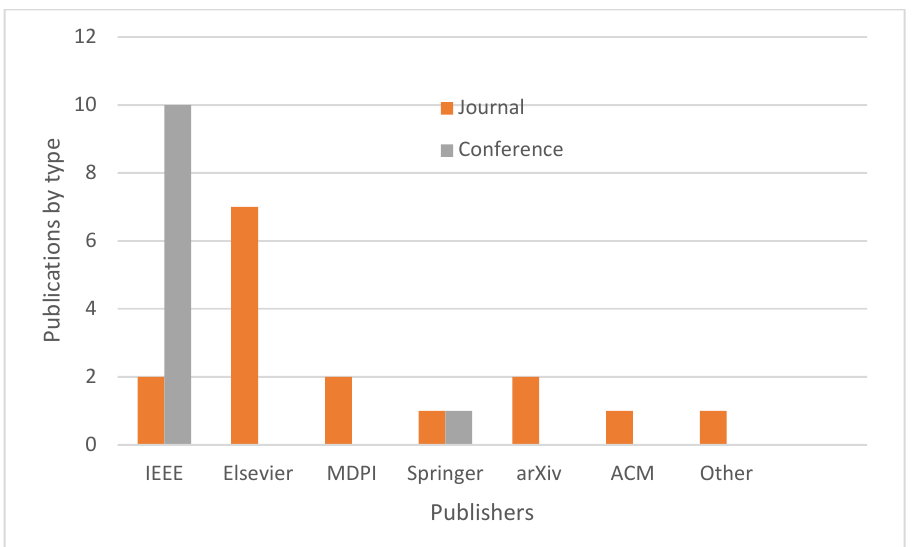
Figure 9. Distribution of the selected papers by type and publisher.